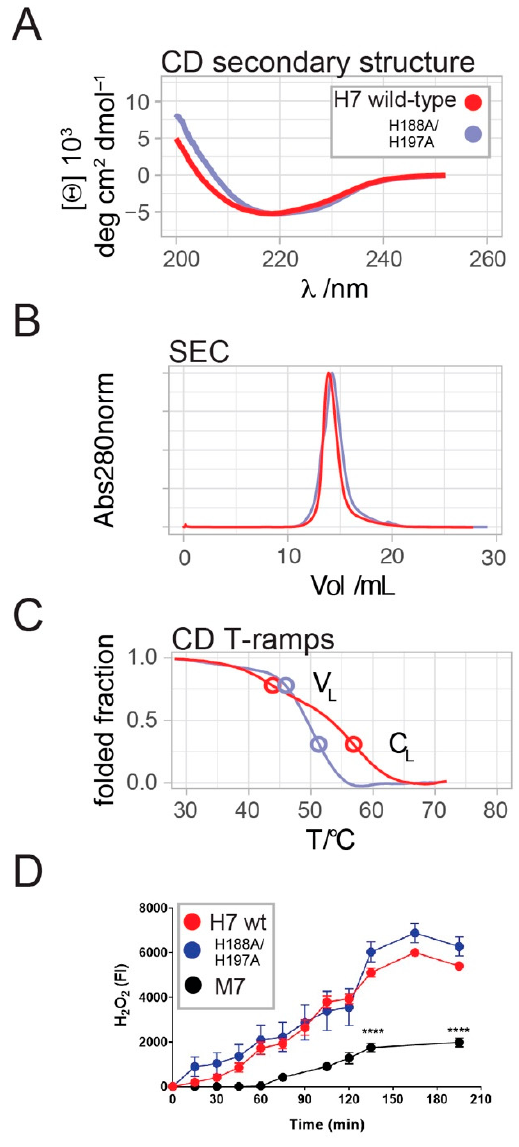
Figure 2. Mutated H7 has a similar overall structure but destabilized C L domain compared to WT, and its capacity to produce H 2 O 2 is unaltered. ( A ) CD spectra recorded for H7 (red) and H7- H188A/H197A (light blue) indicated minimal differences below 210 nm that are possibly caused by minimal loss of the strand and/or helix secondary structure in the C L domain. ( B ) H7 and H7- H188A/H197A eluted from the analytical SEC column Superdex 200 10/300 GL at almost identical retention volumes of 14 mL, corresponding to an apparent MW of 44 kDa. ( C ) Comparative thermal melting of H7 and H7-H188A/H197A monitored at 202 nm in CD revealed that the 2nd inflection point was shifted from 57 to 51.5 °C. This destabilizing effect of the His-to-Ala substitutions in the C L domain allowed us to assign the 1st and 2nd inflection points to the V L and -C L domains, respectively. Although the melting curve of H7-H188A/H197A is more cooperative with a single apparent transition, the hypothetical inflection points of the two domains based on the wild-type profile are indicated. ( D ) H 2 O 2 produced by 50 μ g/mL H7, H7-H188A/H197A and M7, incubated at different times at 37 °C in 10 mM PBS, pH 7.4. The mean ± SD of fluorescence intensity (FI), n = 6. **** p < 0.0001 vs. H7 WT and mutated H7, one-way Anova and Bonferroni’s post hoc test. 2.2. H7-H188A/H197A Mutant Binds Cu 2+ and Produces H 2 O 2 Similar to Wild-Type H7